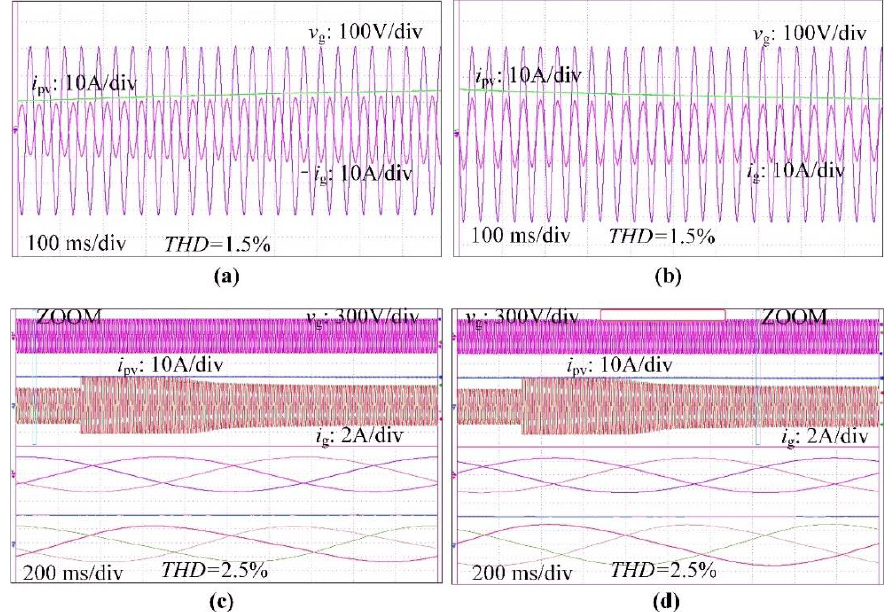
Figure 14. Transient comparison of PV 3CH4 grid-connected power fluctuations in HIL MT5010: ( a ) PV output power increased; ( b ) PV output power decreased; ( c ) before a sudden increase of PV output power; ( d ) after a sudden decrease of PV output power. Table 3. PV wide power fluctuations efficiency